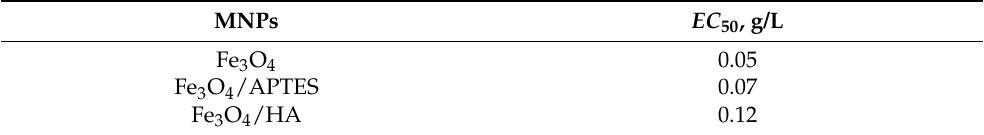
Table 2. Effective concentrations of MNPs, EC 50 (i.e., concentrations inhibiting bioluminescence intensity by 50%).